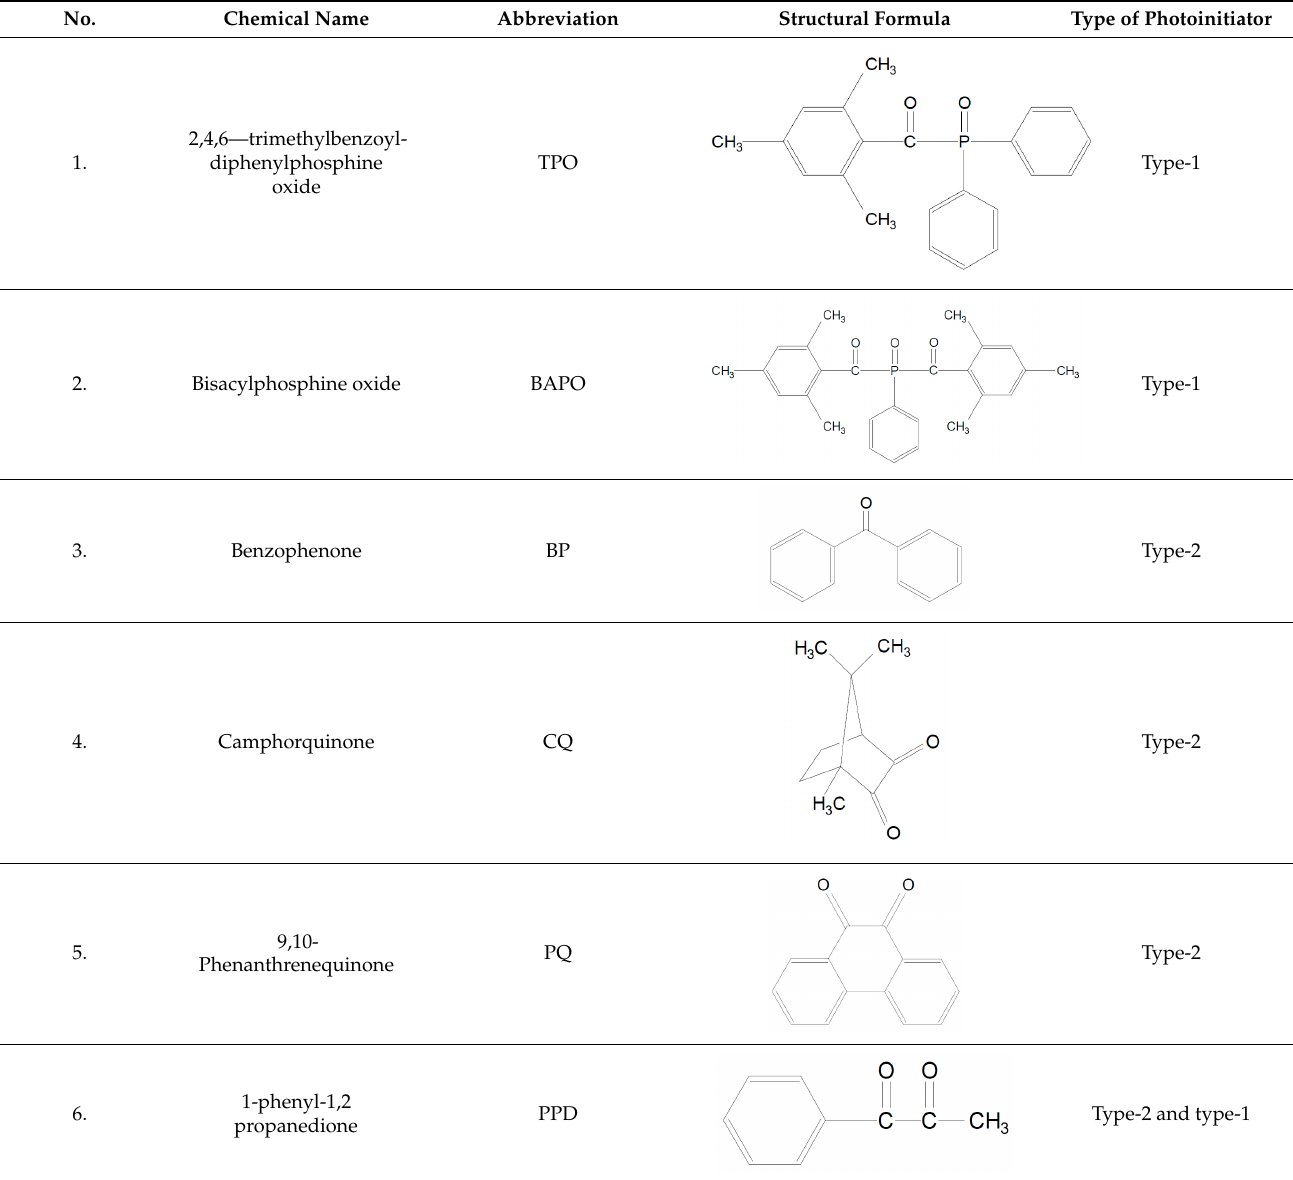
Table 1. Chemical names, abbreviation, structural formula of photoinitiators used in review.